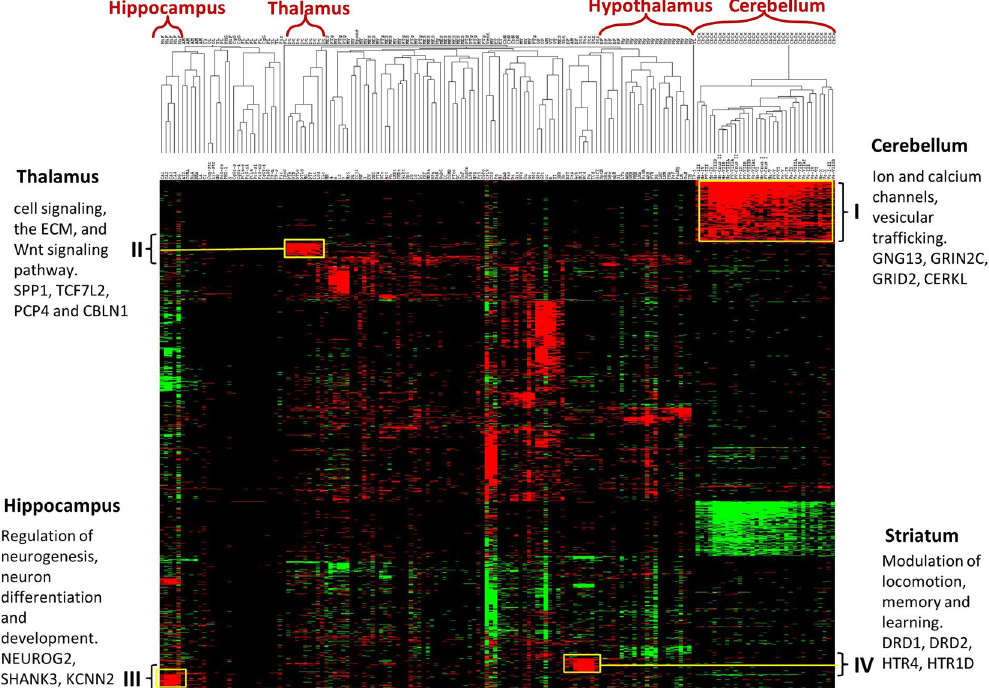
Figure 2. Dendrogram and heat-map overview of the two-way unsupervised hierarchical cluster analysis of gene expression data from 160 samples using 6,984 genes. Columns represent individual brain structures and rows represent each gene and the z-scores were calculated across rows. The expression level of each feature (gene) in every brain structures is represented as a cell in a two dimensional matrix. Red and green reflects up and down regulated expression levels, respectively, in a given brain structure with respect to all the other brain structures. Large transcriptional differences are seen between major structures. Cerebellum displays the minimum internal heterogeneity whereas there is a clear distinction in the expression patterns of cortical regions especially motor and sensory